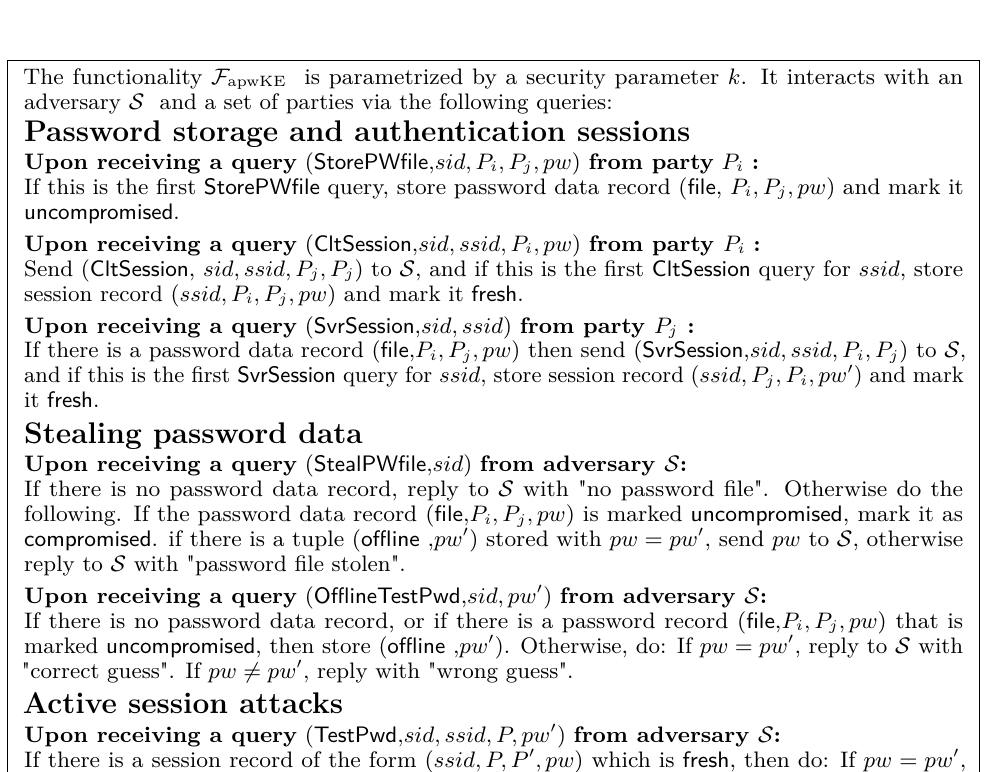
Figure 8: Ideal functionality F apwKE for verifier-based PAKE with explicit